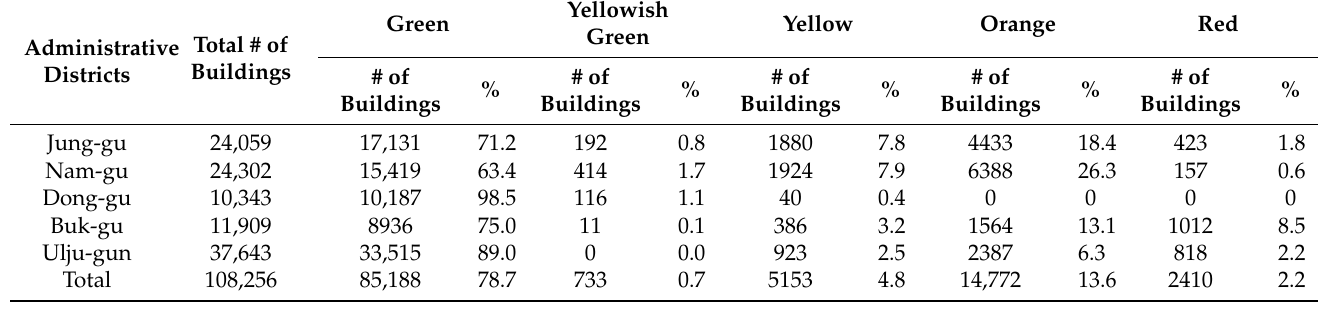
Table 9. Classification by building on urban flood risk.